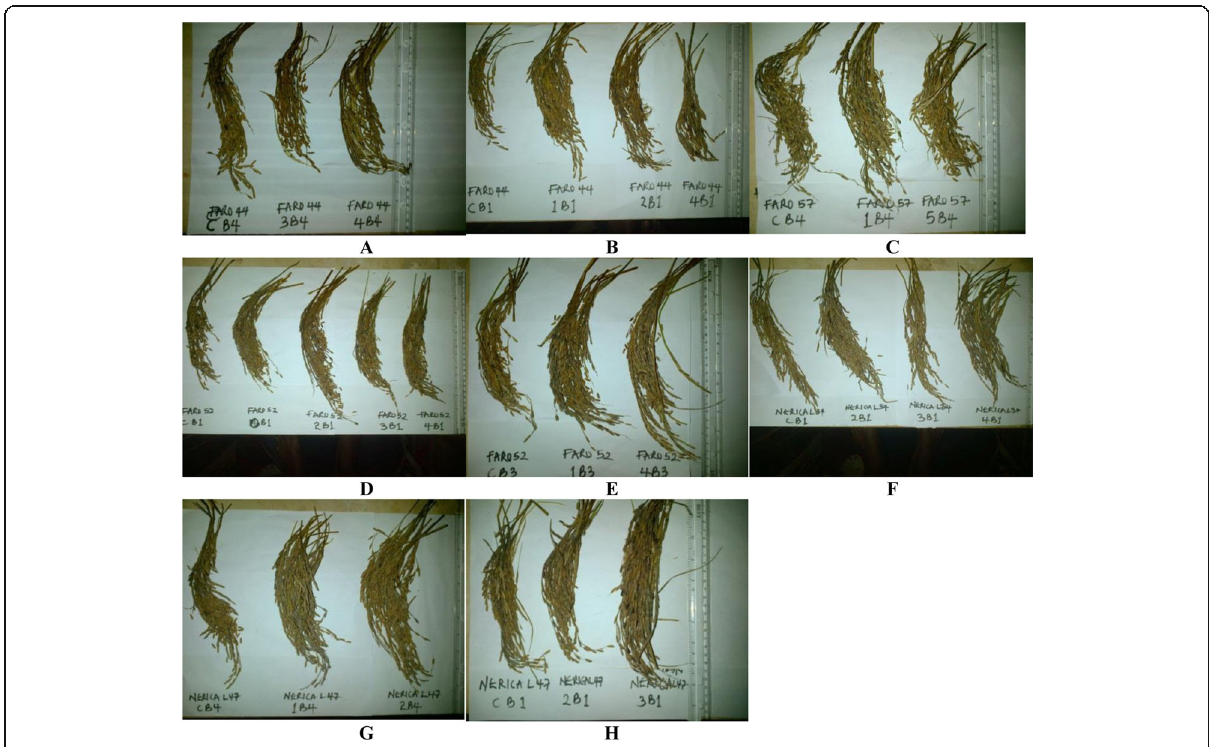
Fig. 5 Harvested panicles of control and treated plants. a and b Comparing panicles of control and NaN 3 -treated plants in FARO-44. c Comparing panicles of control and NaN3-treated plants in FARO-52. d and e Comparing panicles of control and NaN 3 -treated plants in FARO-57. f Comparing panicles of control and NaN 3 plants in NERICA L-34. g and h Comparing panicles of control and NaN 3 -treated plants in NERICA